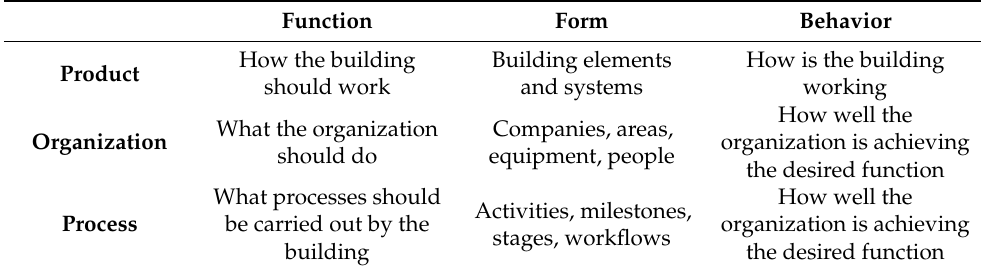
Table 1. POP matrix, adapted from the studies by Bicharra et al. [16], Khanzode et al. [20] and Kunz & Fischer [12].